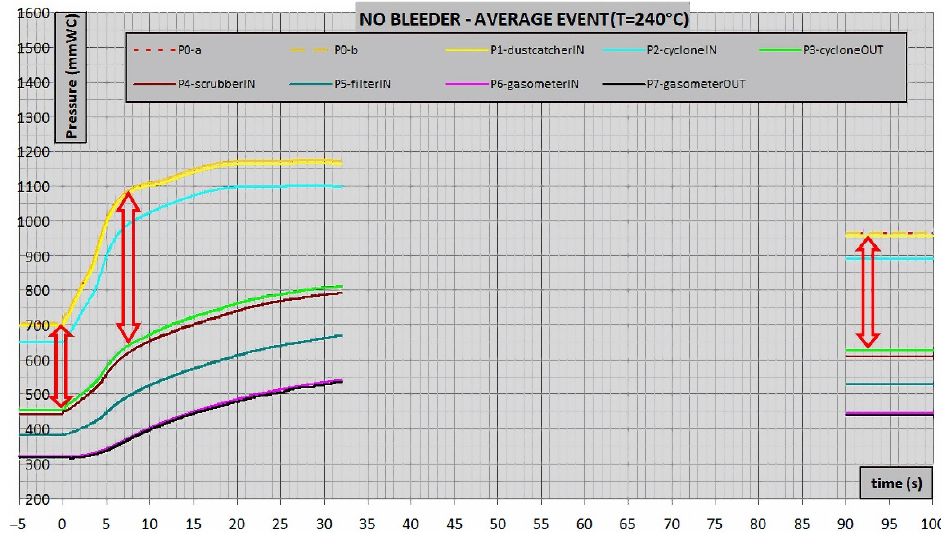
Figure 11. Evolution over time of pressure measures along the original circuit in the hypothesis there are no bleeders. The transient simulation stopped at about the maximum value of the BF top gas pressure because transitory in time is not significant. The new equilibrium condition is calculated with a steady state simulation.